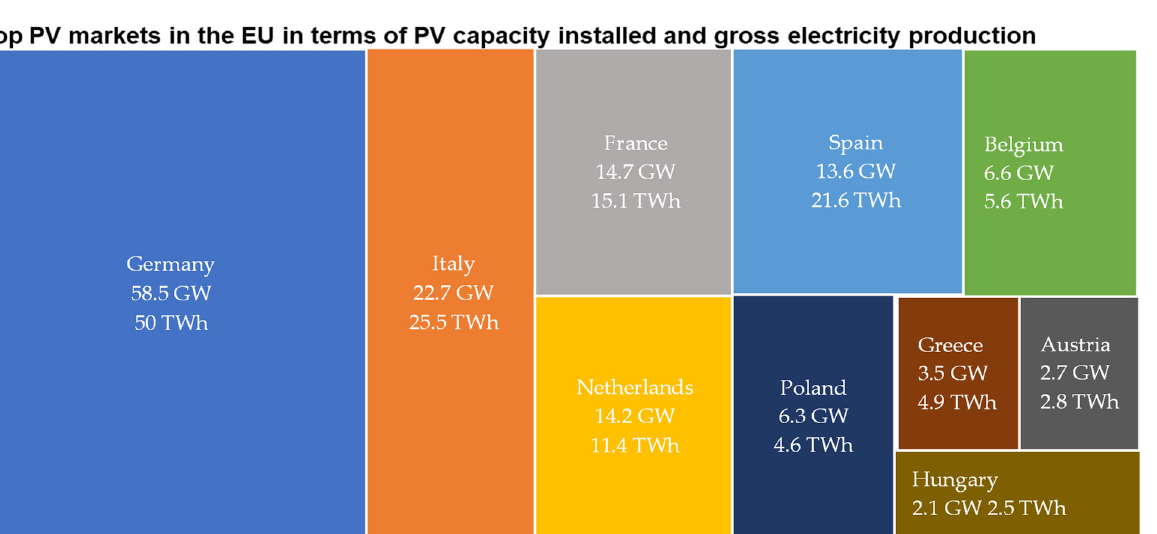
Figure 1. Characteristics of top PV markets in the EU—data for 2021.